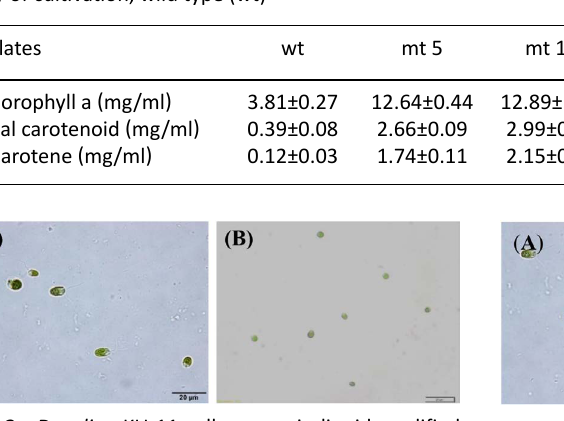
Fig. 3. D. salina mutants KU 18 cells grown in liquid modified Johnson’s medium containing 2.5 M NaCl at 3 rd day (A) and 12 th day (B) of incubation, observed microscope